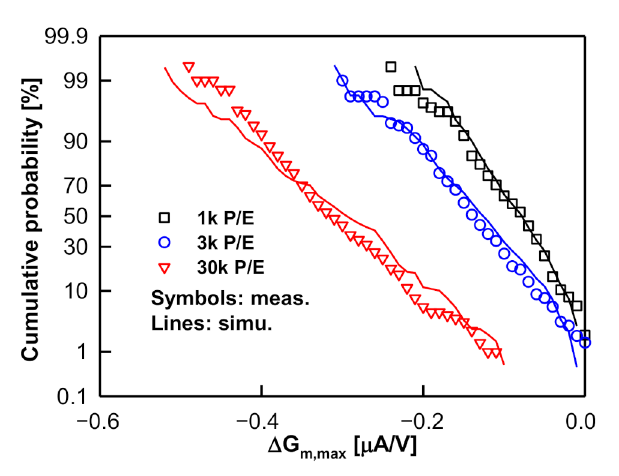
Figure 9. Simulated ∆ G m , max statistics for different number of P/E cycles. The simulations and experimental measurements are in good agreement. Reprinted from [39].